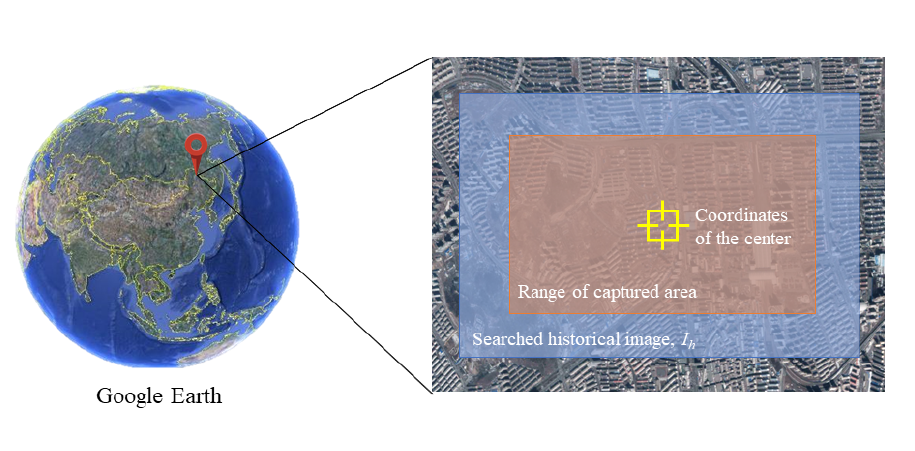
Figure 2. The process of searching for historical